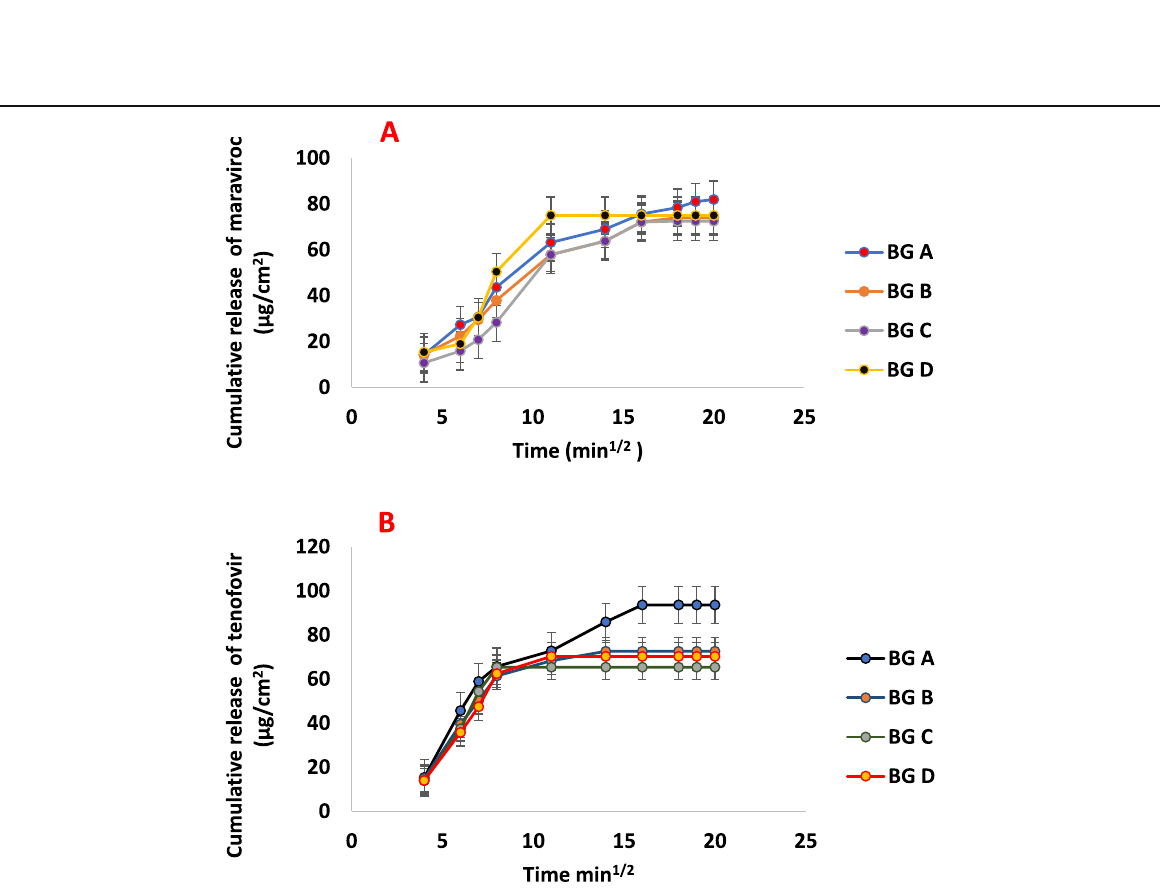
Fig. 3 a Cumulative release of maraviroc from bigel formulations. b Cumulative release of tenofovir from bigel